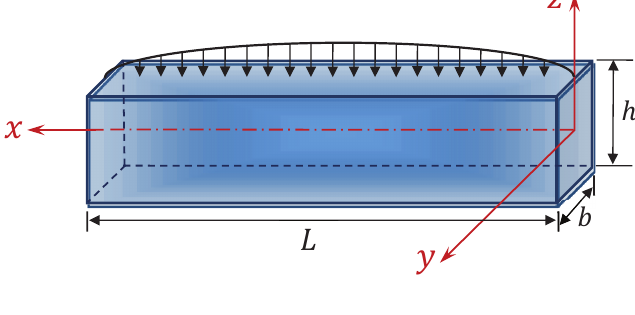
Figure 1. Schematic diagram of the